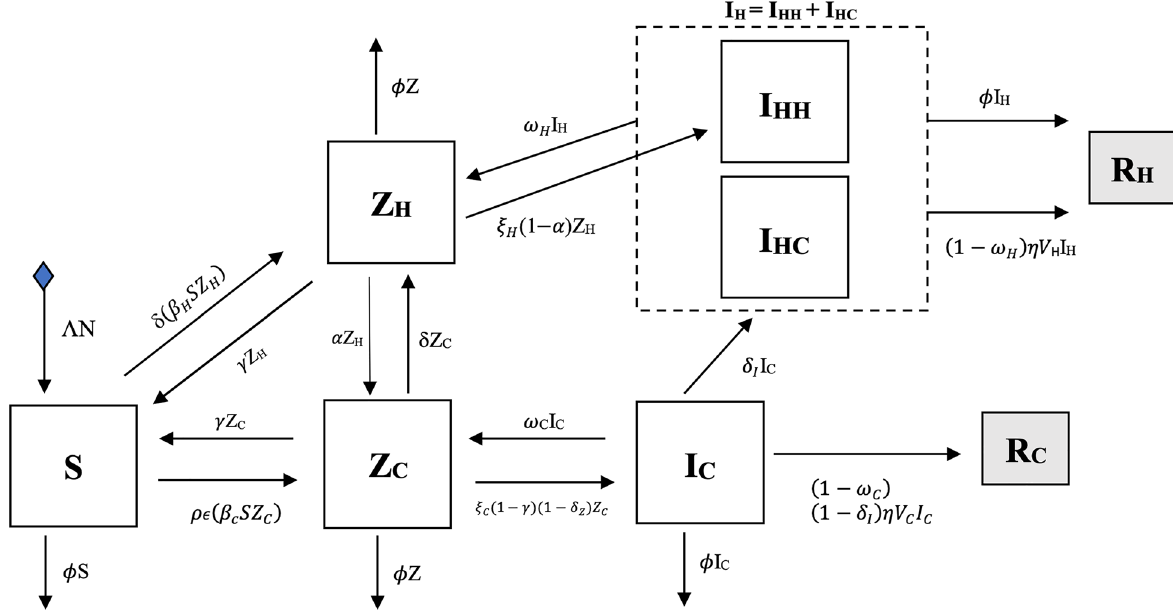
Figure 5. Compartment model for GN-ARB community transmission. Notes: Tables 1 and 2 show baseline conditions and parameter specifications of the compartment model. Subscript “H” stands for hospital population whereas “C” for community. I H is divided into I HH and I HC for hospital- and community-acquired BSIs. The compartment S indicates that the whole cohort is susceptible to antibiotics because gram-negative bacteria are an essential part of human gut microbiota and other mucosal surfaces. Infectiousness (I) occurs after being colonised (Z) by resistant bacteria. Individuals are immediately transferred to the susceptible S(t) disease-free population compartment after full clearance of infection. The model assumes that people can be infected only by one type of resistant bacterium simultaneously, which cannot evolve. (R) compartments are for removed individuals